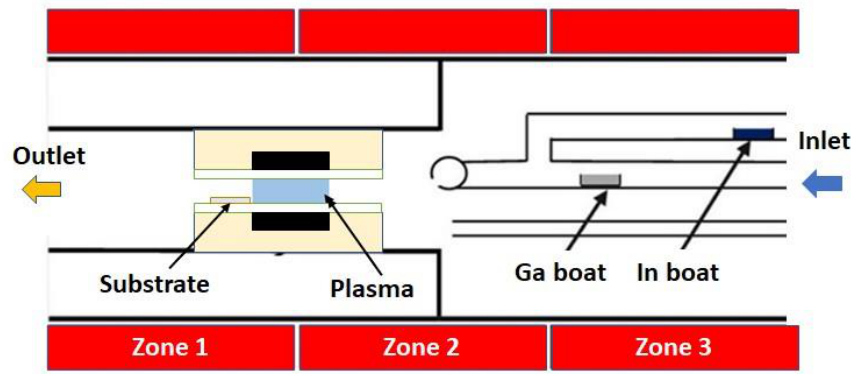
Figure 1. Schematic drawing of the HVPE reactor.